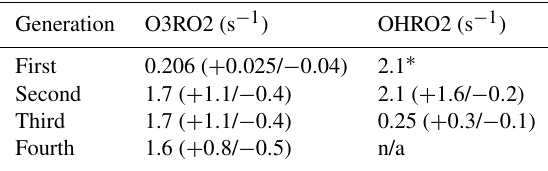
Table 4. Autoxidation coefficients for peroxy radicals after fitting to experimental data (at 297K) with estimated